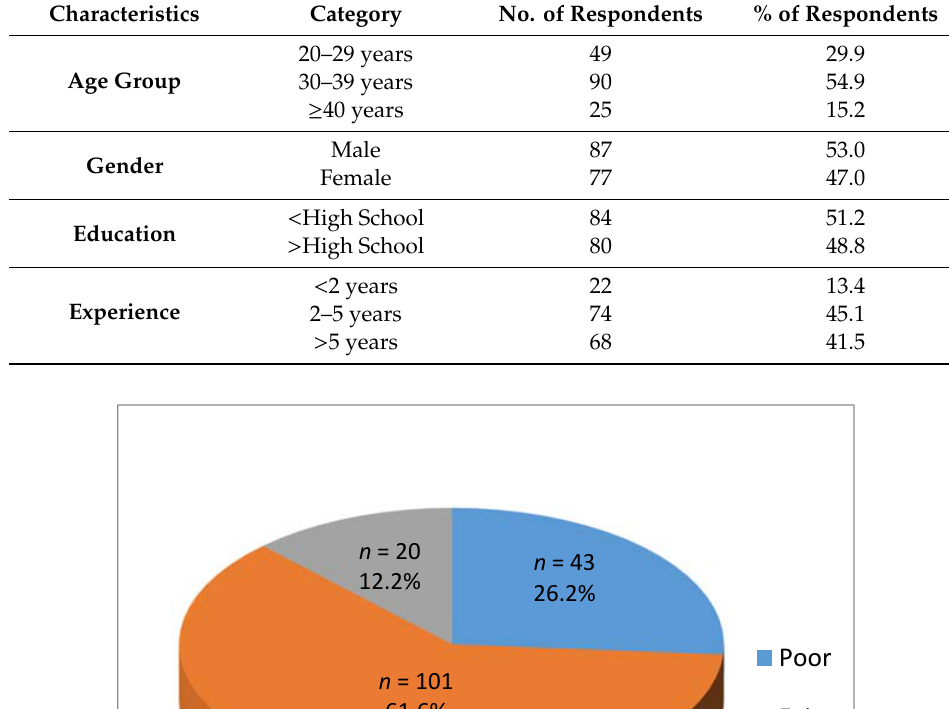
Table 1. Distribution of the demographic characteristics of the respondents who participated in the study.